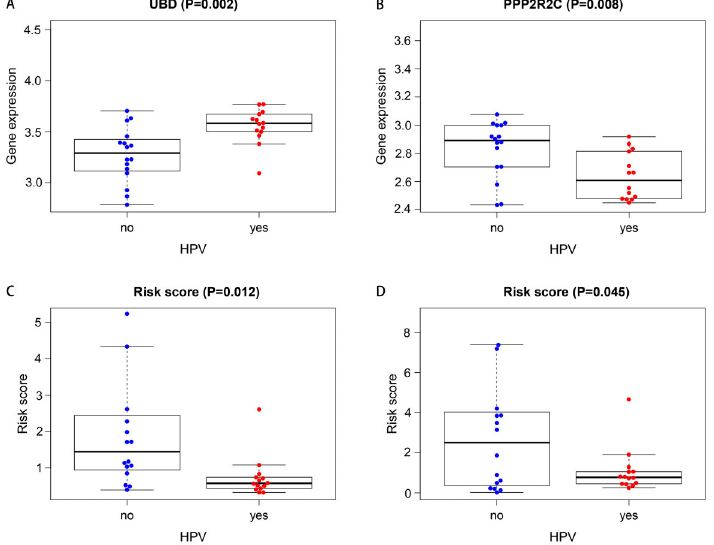
Figure 8. Correlations between signi fi cantly differential genes (SDGs) and clinical features. A , UBD expression level and human papillomavirus (HPV) status. B , PPP2R2C expression level and HPV status. Risk score level and the HPV status in the disease-speci fi c survival (DSS) ( C ) and progression-free survival (PFS) ( D ) groups. Data are reported as medians and interquartile range (Student ’ s t